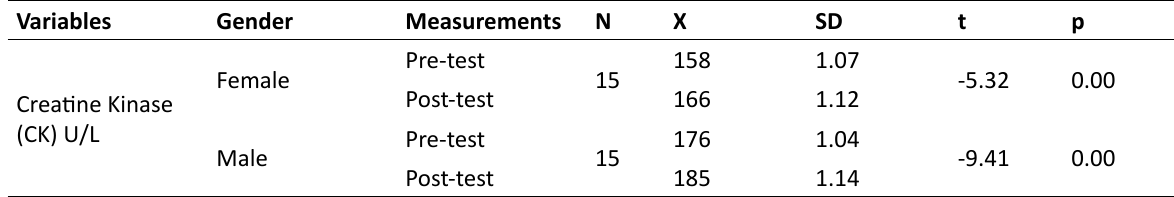
Table 4. The Creatine Kinase Pre-test and Post-test Results of Participant Females and Males